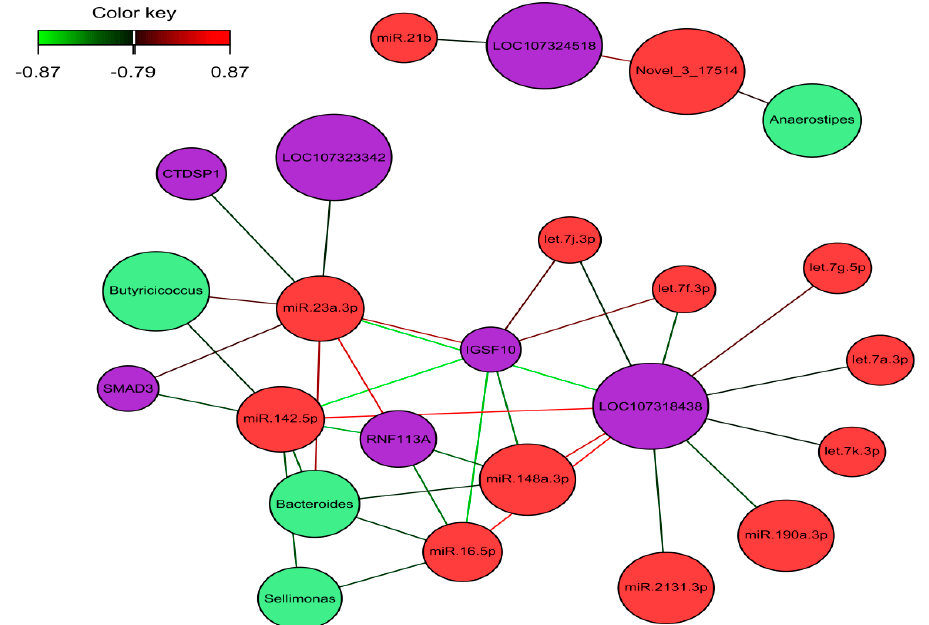
Figure 8. Network visualization of miRNA, mRNA, and microbiota panel, highlighting correlated variables ( r > | 0.79 | ). Color nodes indicate microbes in green, mRNA in violet and miRNA in red. Edge color indicates the correlation between nodes as shown in the color key. Green edges indicate a negative correlation, red edges indicate a positive correlation.